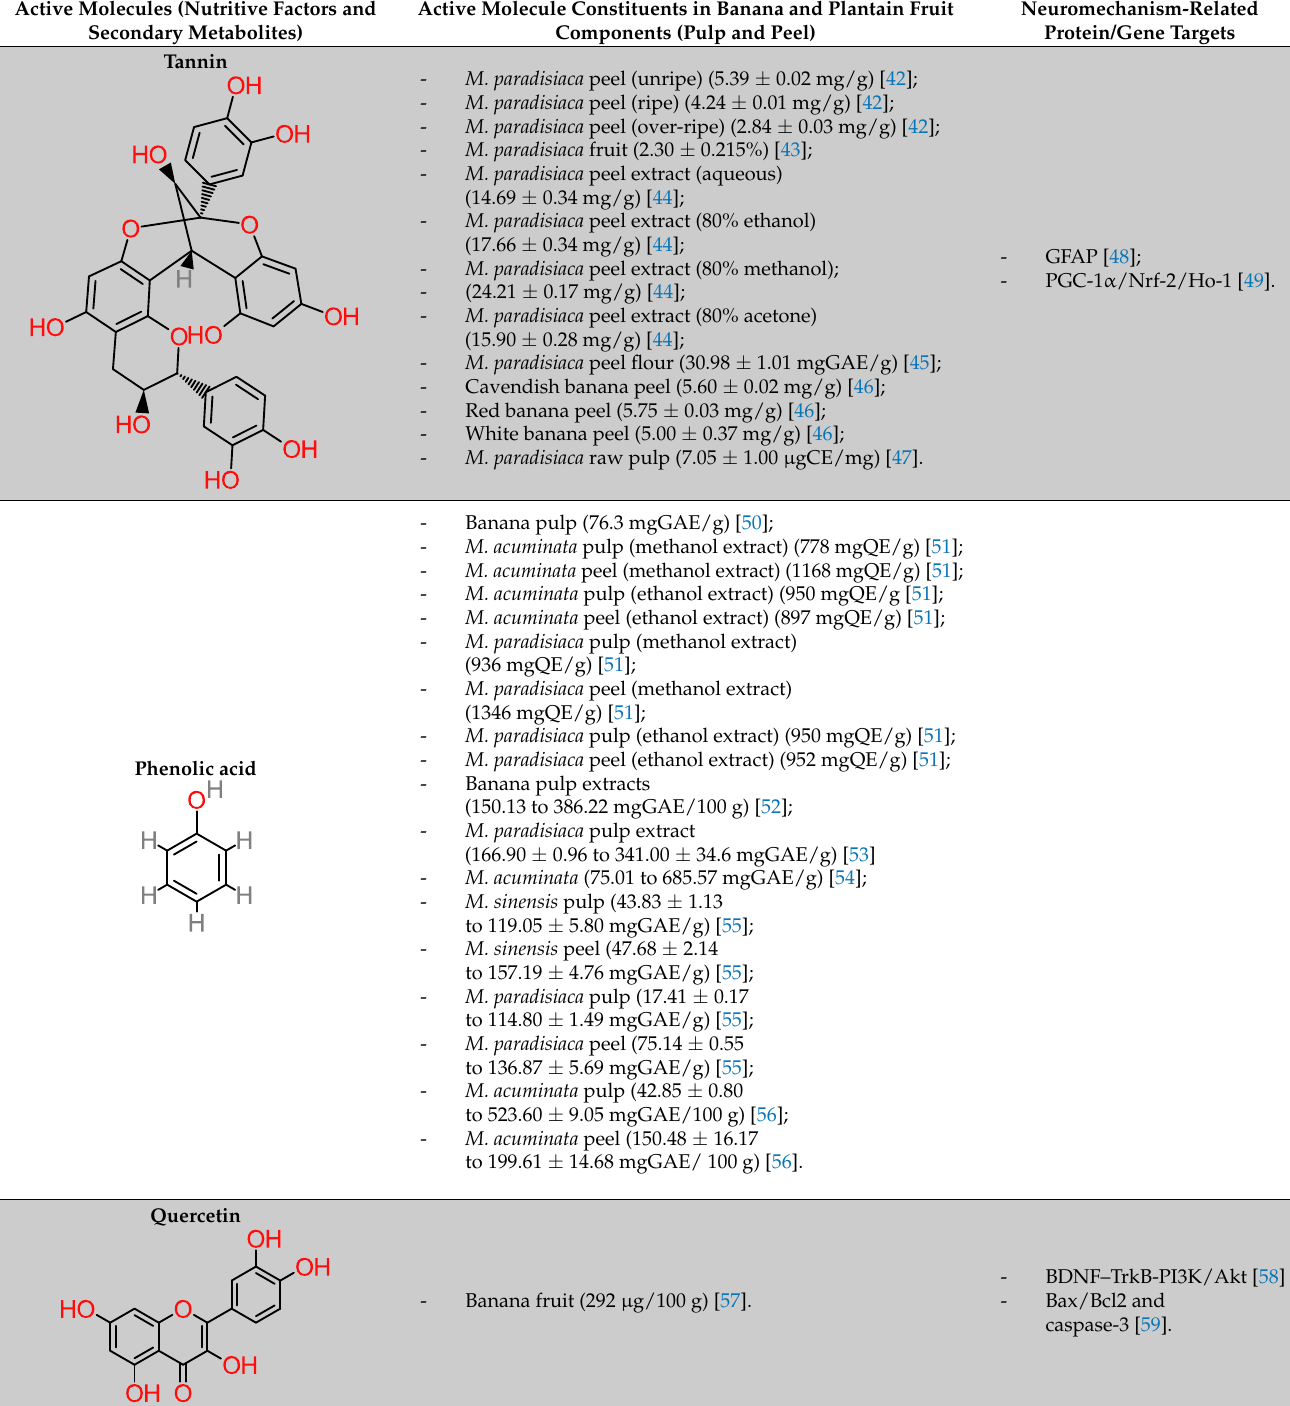
Table 1. Compendium of active molecules in banana and plantain fruits. Active Molecules (Nutritive Factors and Secondary Metabolites) Active Molecule Constituents in Banana and Plantain Fruit Components (Pulp and